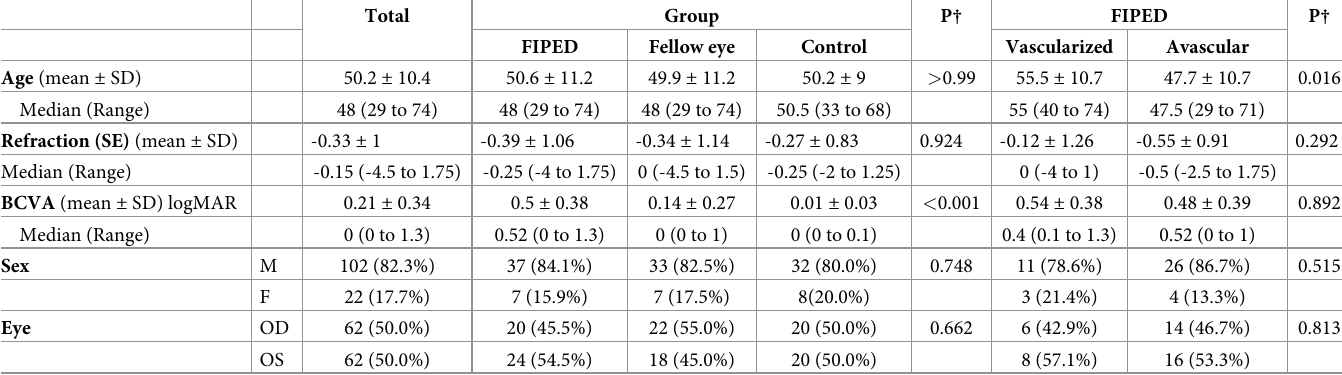
Table 1. Demographics of patients with chronic CSC in different groups.